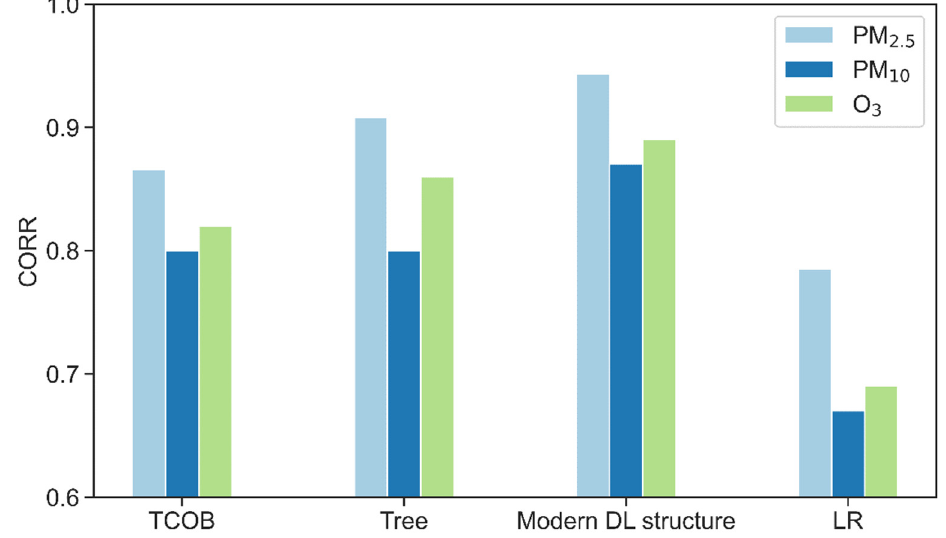
Figure 3. Model performance in main atmospheric pollutants: PM 2.5 , PM 10 , and O 3 .